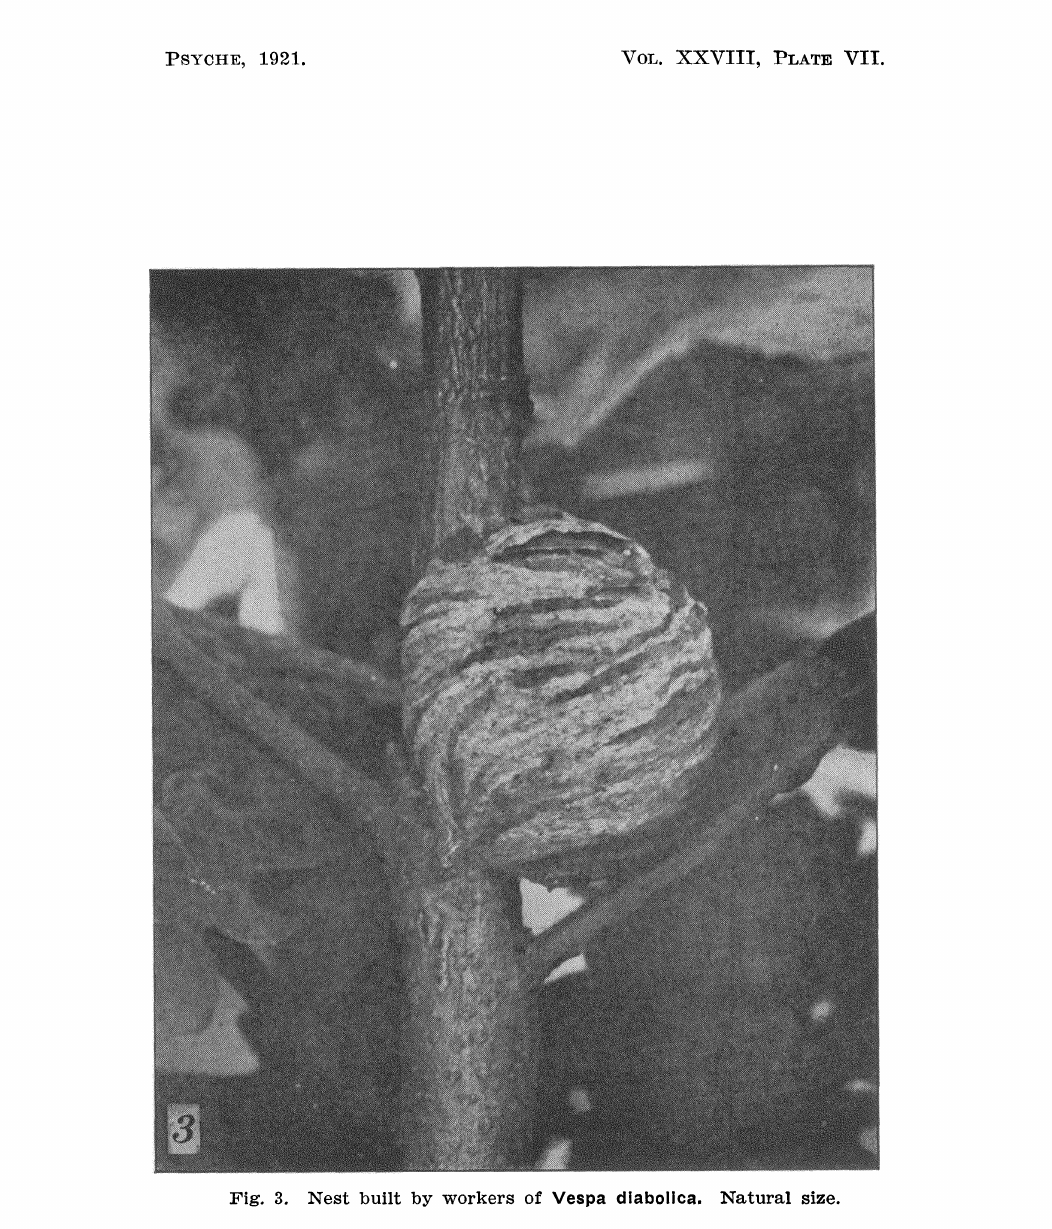
Fig. 3. Nest built by workers of Vespa dlabolica. Natural